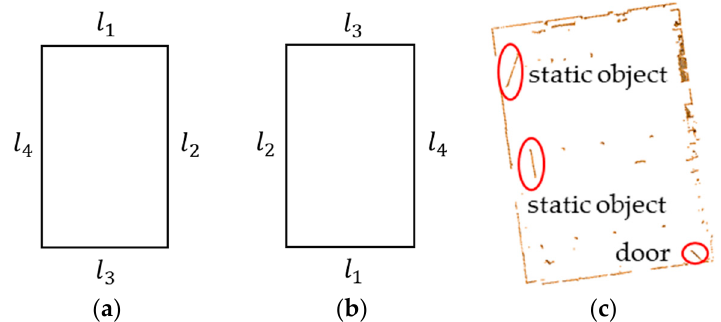
Figure 13. Ambiguity situations in line-based ortho-projected image matching. ( a ) ortho projected image of a rectangle room; ( b ) ambiguity situation of ( a ); ( c ) doors and static objects in the room.